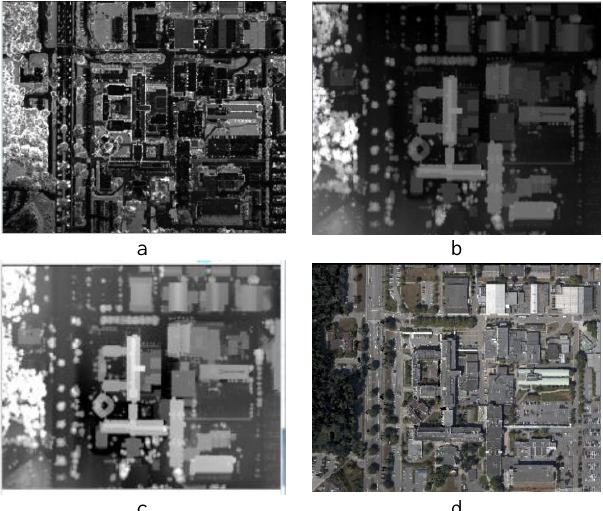
Figure 3: a) Geometrically Calibrated and Radiometrically corrected Intensity Image, b) DSM, c) NH, and d) Ortho-rectified Aerial